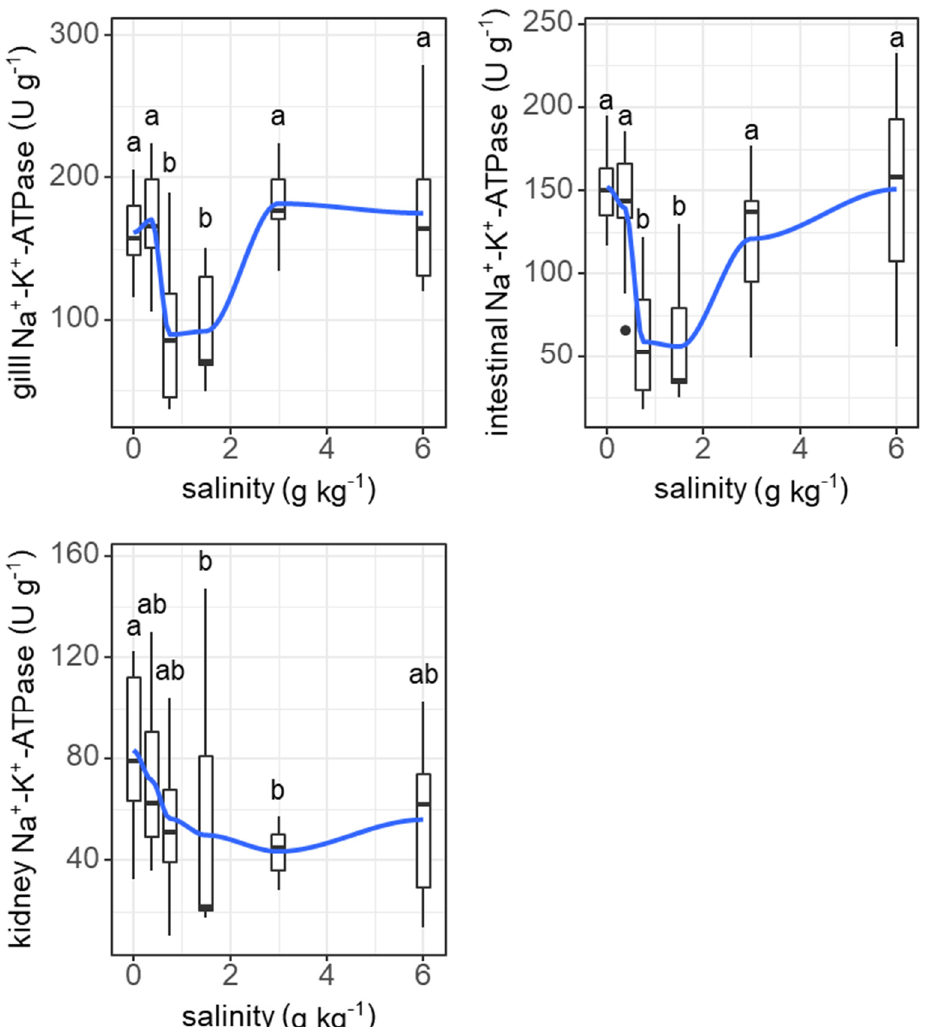
Figure 8. Effects of salinity on Na + -K + -ATPase activities in gills, intestine, and kidneys of grass carp. The data are expressed as boxplots, with boxes indicating the upper, middle, and lower quartiles, and vertical lines indicating the upper whisker and lower whisker. The blue curve describes the changing tendency using locally weighted scatterplot smoothing (LOWESS). a,b: Boxes without common superscripts indicate significant differences among the treatments ( p < 0.05). Black dot: the outliers.